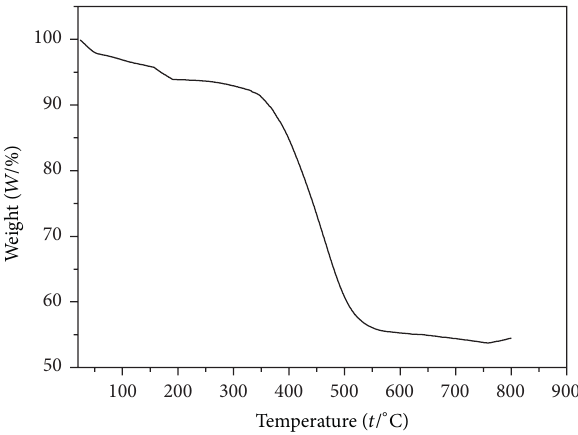
Figure 5: The TGA curve of the composite films at 20 ∘ C to 800 ∘ C.